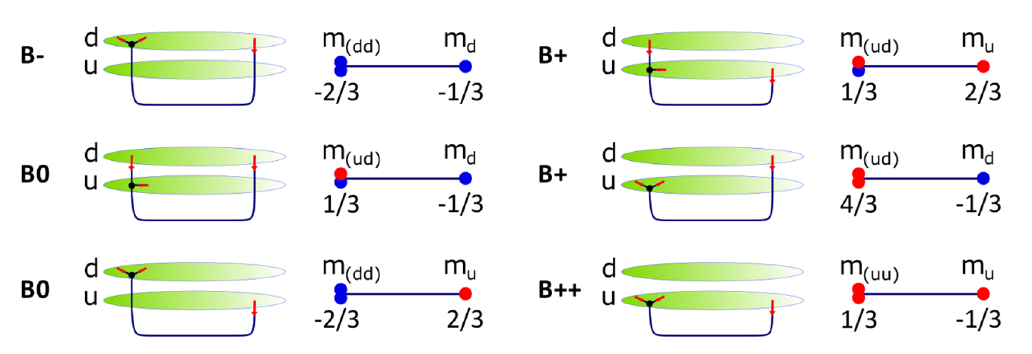
Figure 2 . The holographic stringy con(cid:12)gurations for baryons with charges (cid:0) 1 ; 0 ; +1 ; +2 associated with the u and d (cid:13)avor branes (left) and the corresponding HISH mesons (right). The diquarks are constructed from a baryonic vertex and two short strings, but are mapped to endpoint particles like the